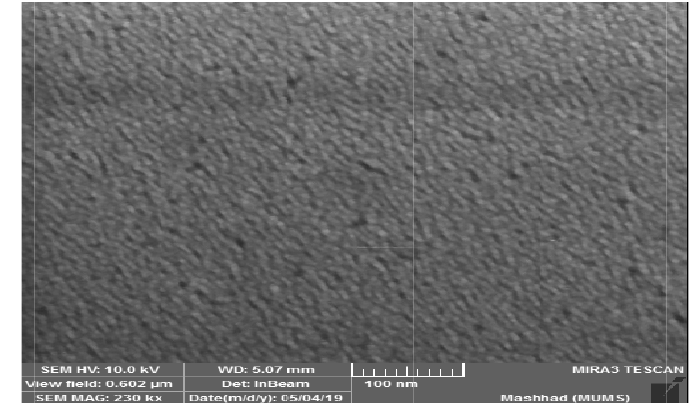
Fig g.5: SEM of p